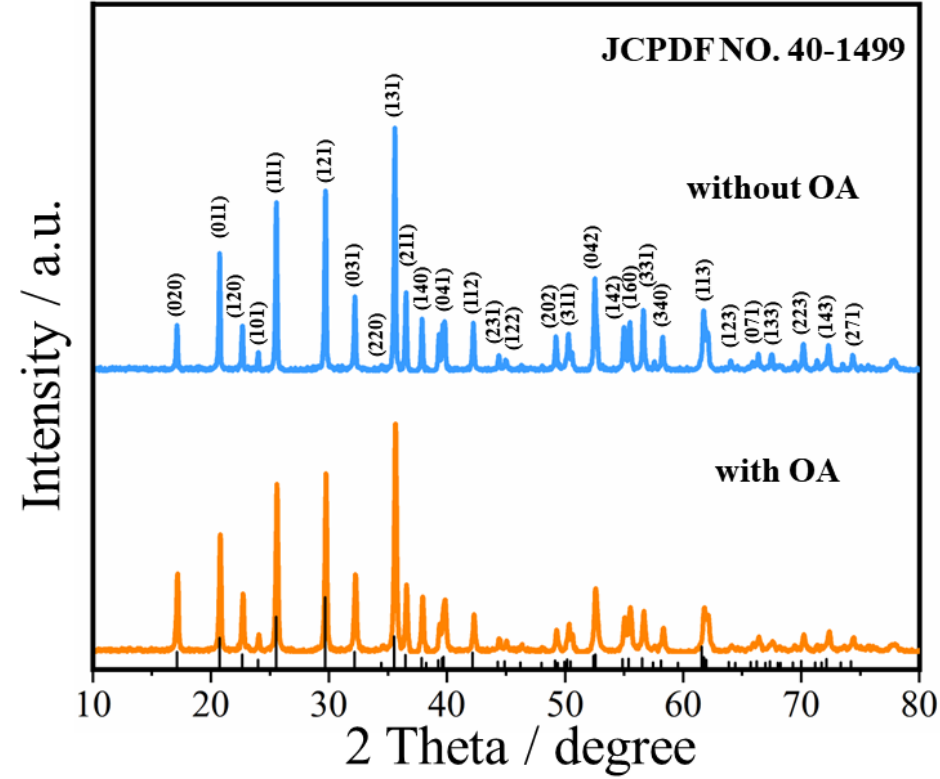
Figure 1. XRD patterns of LiFePO 4 prepared without and with OA. Table 1. Some XRD and electrochemical parameters of the LiFePO 4 electrodes prepared without and with OA.